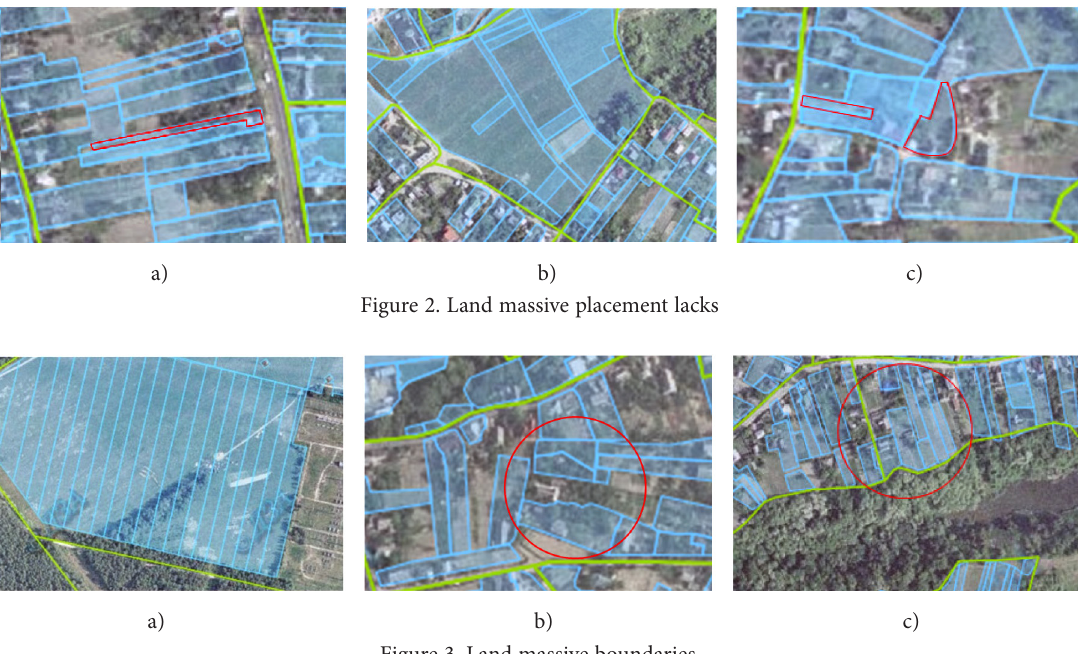
Figure 3. Land massive